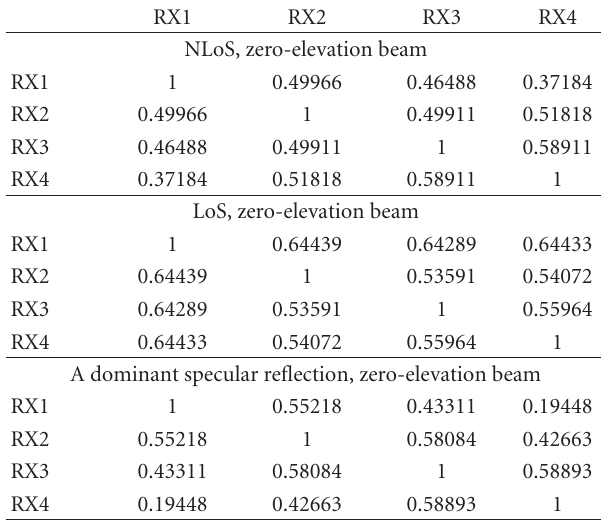
Figure 11: BER as a function of the normalized received E b /N 0 per antenna, recorded along the LoS path with the transmit antenna array oriented towards the receiver, for transmissions at equal total E b ,tr .